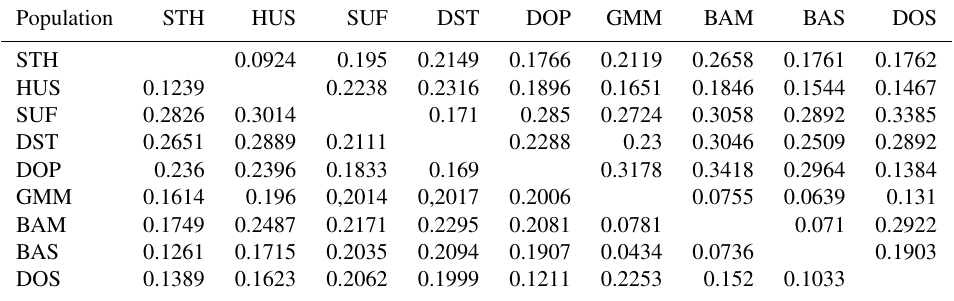
Table 5. Nei’s genetic distances (above the diagonal) and Nei’s standard genetic distances (below the diagonal) for nine sheep populations. Population STH